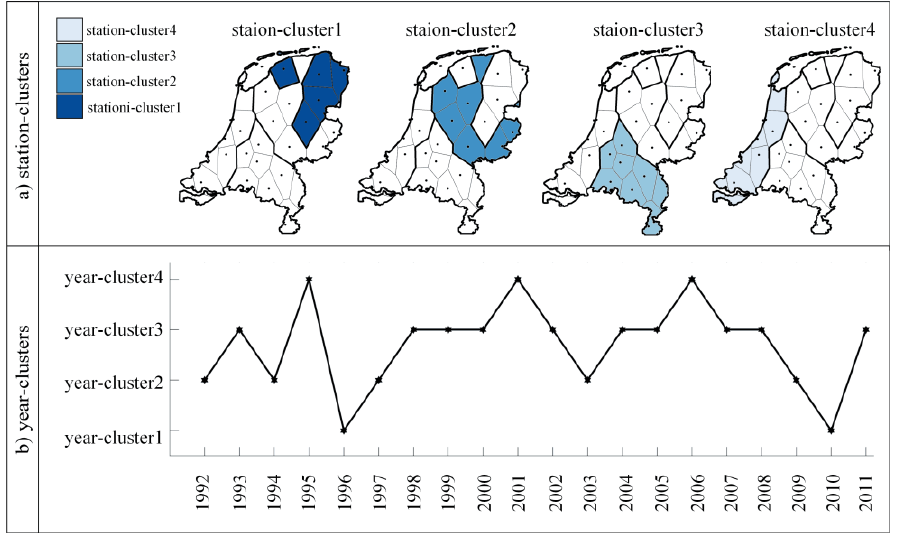
Figure 6. Spatio-temporal clusters (( a ) station-clusters; ( b ) year-clusters)) identified in Dutch temperature data at the monthly resolution.